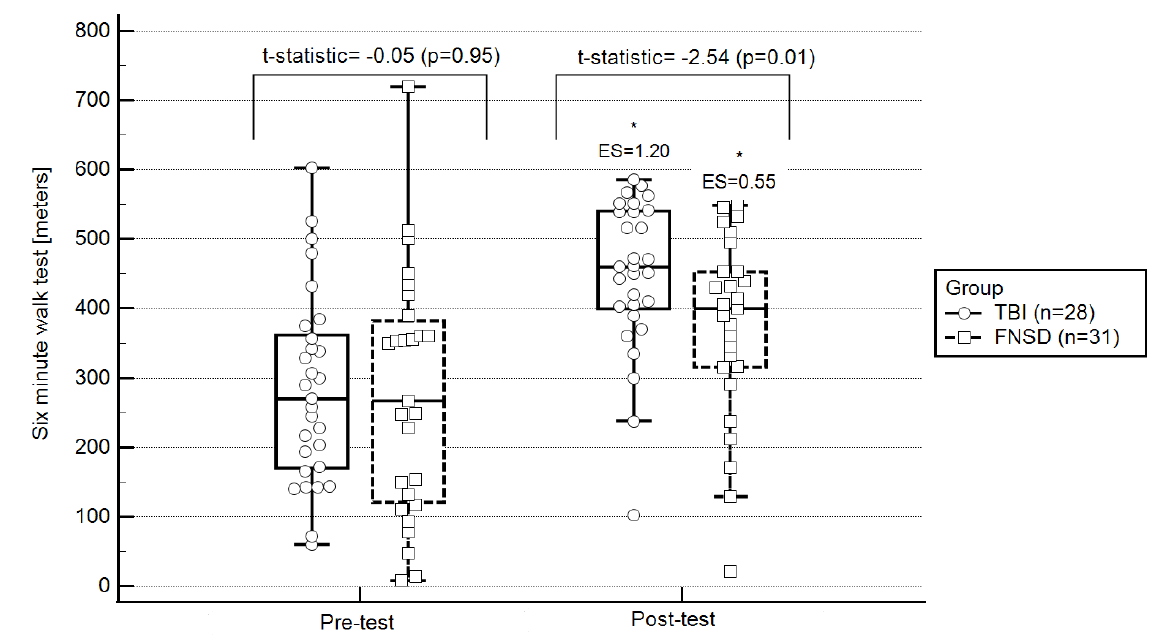
Figure 2. Pre- and post-test walking ability: within- and between-group differences. Notes: * statistically significant within-group changes ( p < 0.05; 2-tailed); ES, effect size of within-group changes from pre-to post-test (ES is based on a single pooled standard deviation (Cohen’s d = mean ∆ /standard deviation average from two means ) and was corrected for dependence between means); FNSD, functional neurological symptoms disorder; TBI, traumatic brain injury; central box, values from the lower to upper quartile (25 to 75 percentile); vertical line, minimum to the maximum values; middle line, median.